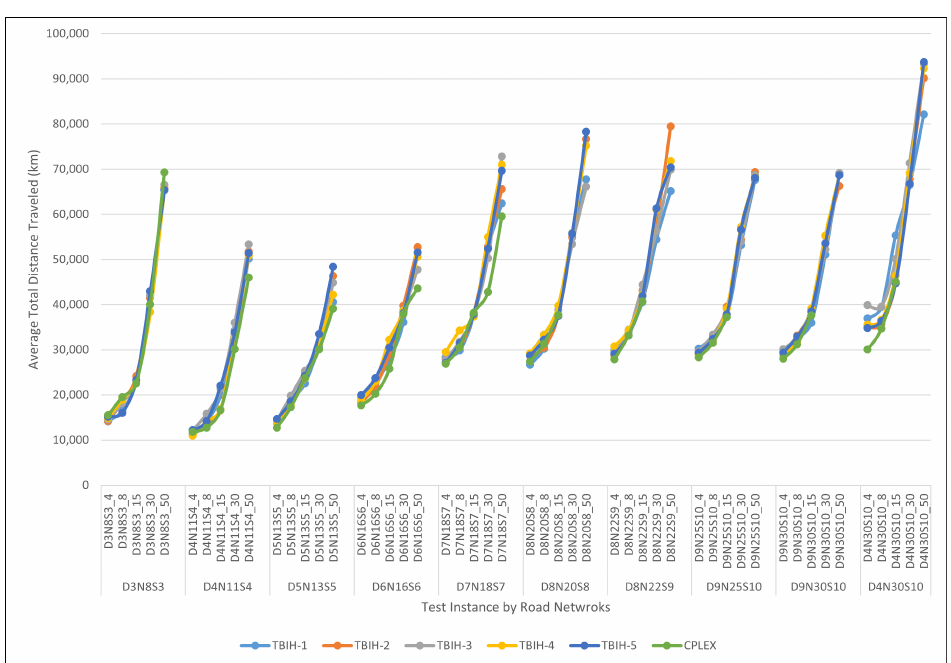
Figure A12. Algorithms performance compared to matheuristic rollout applied in PDS-RA: average total distance travelled (km) based on test instances.